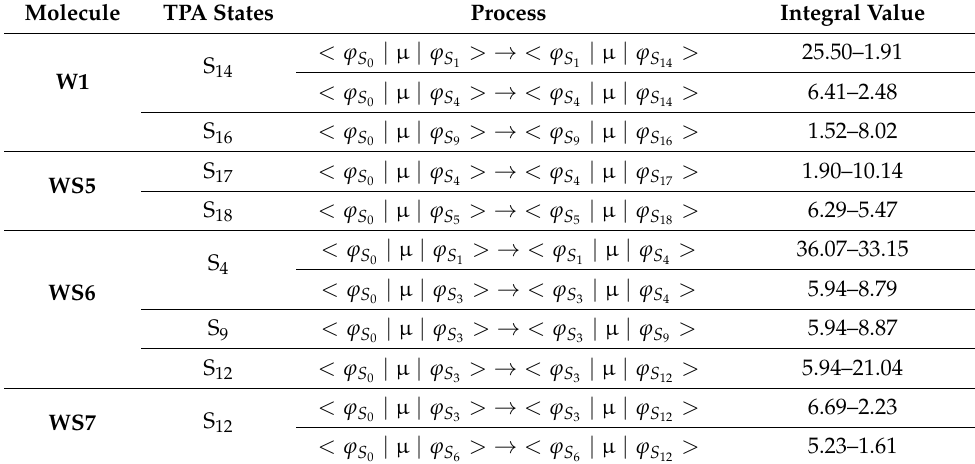
Table 4. TPA element of the transition dipole moment matrix of four